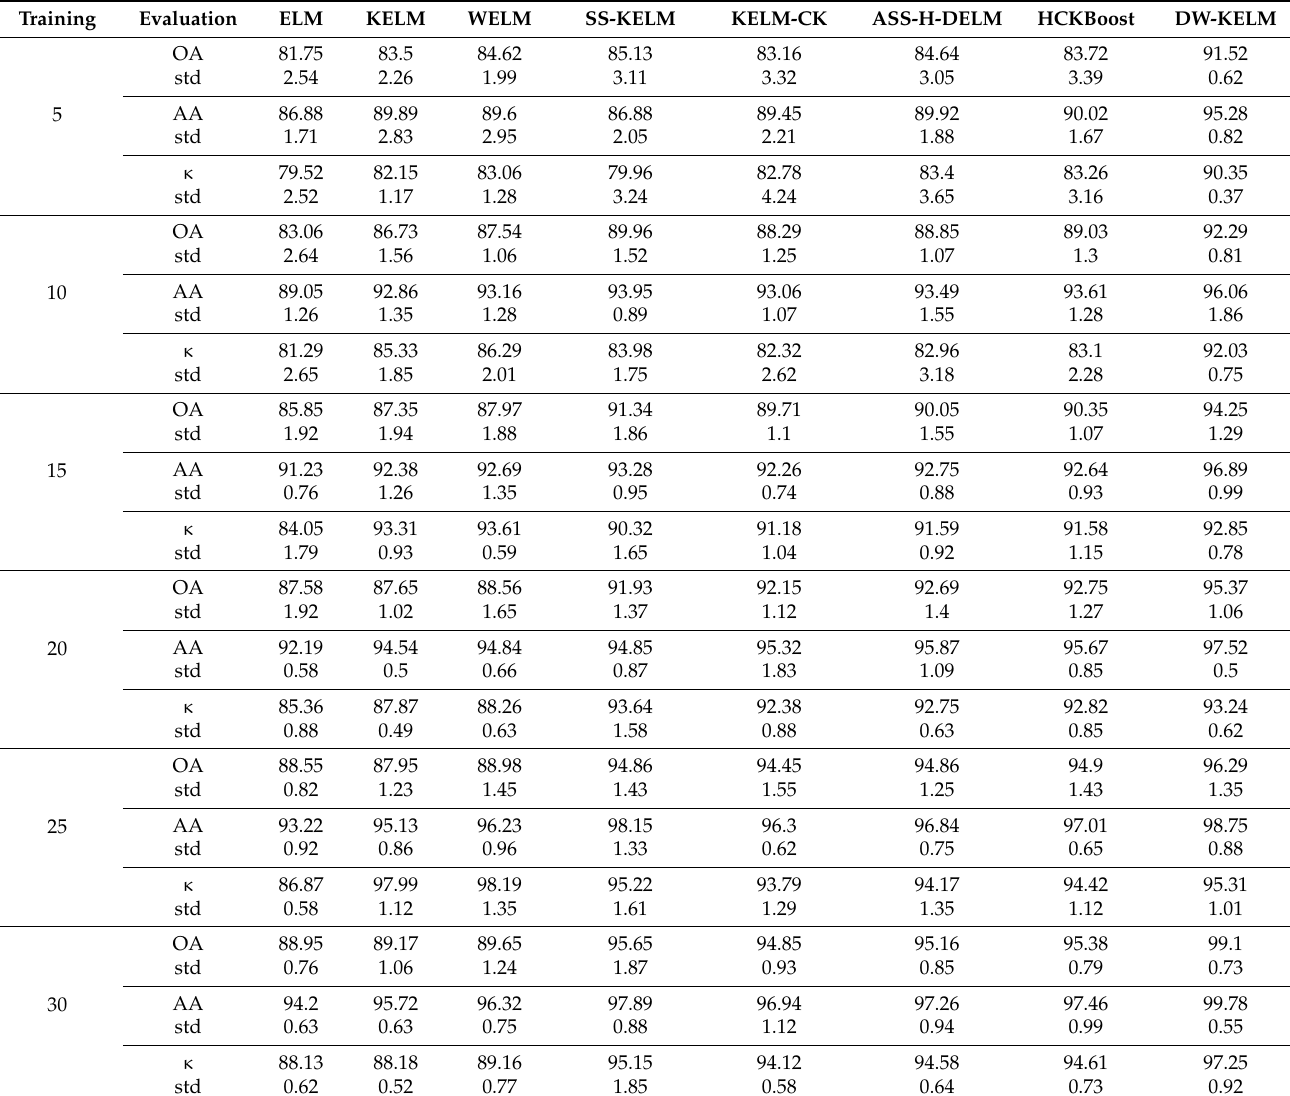
Table 6. Results obtained with different training numbers of labeled samples per class on the Salinas data set.